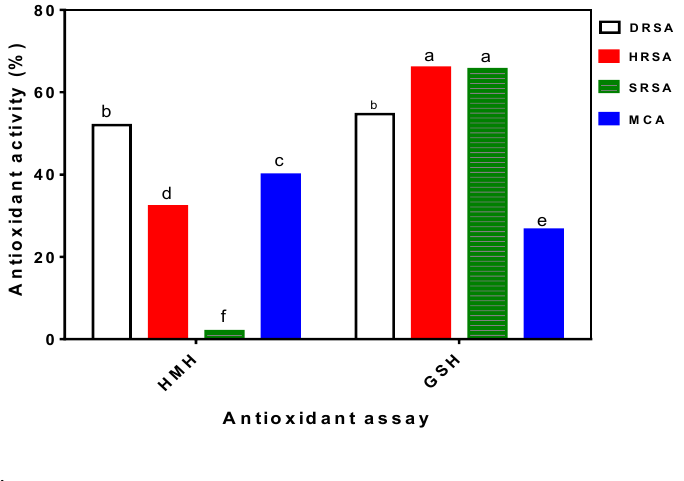
Figure 1. In vitro antioxidant properties of hemp seed meal hydrolysate (HMH) and glutathione (GSH) at 1 mg/mL concentration. DRSA, DPPH radical scavenging activity; HRSA, hydroxyl radical scavenging activity; SRSA, superoxide radical scavenging